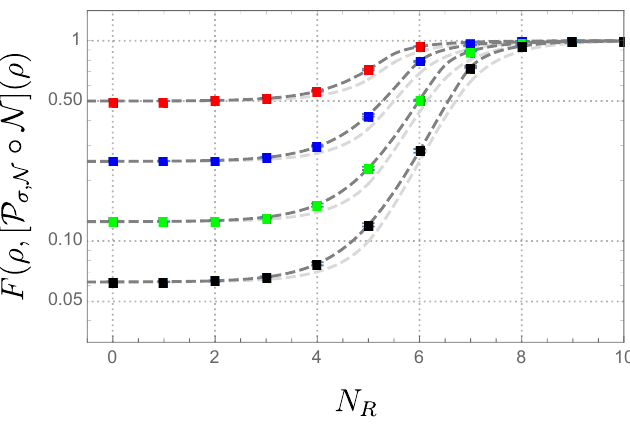
Figure 17 . The fidelity of the Petz map for the Hayden-Preskill protocol at infinite temperature, as a function of the number of qubits N in the radiation. The total number of qubits in the black R hole and the radiation is 10 in all cases, and the different curves correspond to different sizes of the diary, ranging from 1 to 4 qubits from top to bottom. The gray dashed curve is the analytic result given by (6.40). The light gray curves are the lower bounds set by the change in relative entropy. In the numerical data, we take a fiducial pure state tensored with the diary state and apply a random unitary matrix and partial trace, followed by the Petz recovery map. We numerically evaluate the between this recovered state and the initial state. Again, we show the average over 10 3 disorder realizations and the corresponding error